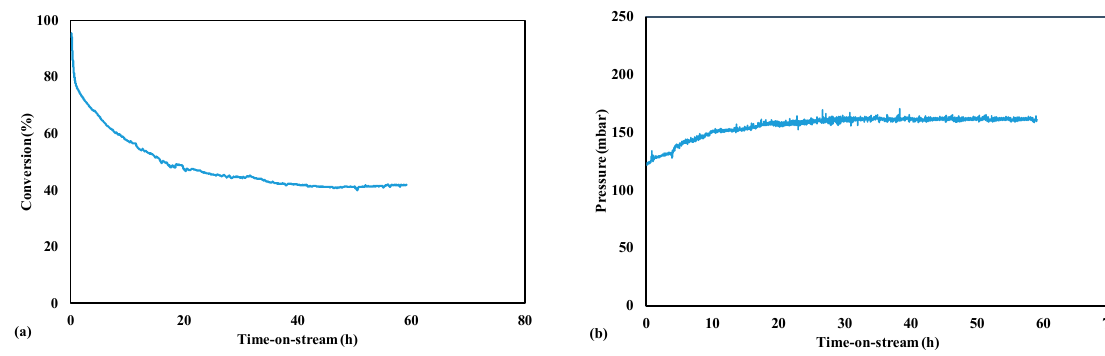
Figure 6. Results of stability test performed over Pt ‐ Ni/CeO 2 /SiO 2 catalyst at 500 °C, H 2 O/EtOH = 4, O 2 /EtOH = 0.5 and WHSV in the interval 4.1–123 h − 1 .